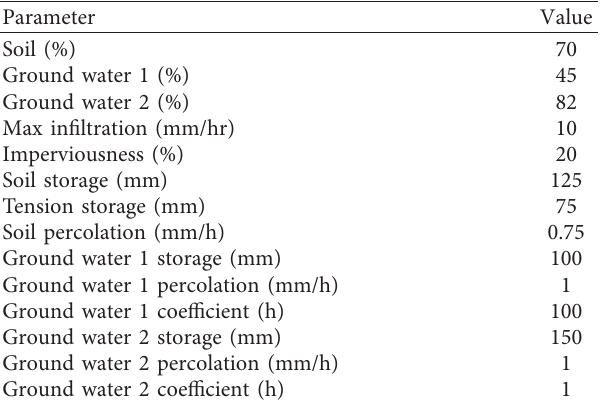
Table 2: Calibrated values of parameters of the soil moisture ac- counting